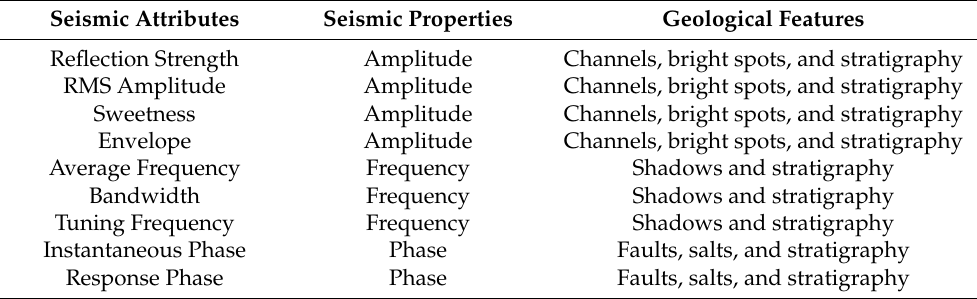
Table 1. Seismic attributes with key seismic properties and the geological applications. Seismic Attributes Seismic Properties Geological Features Reflection Strength Amplitude Channels, bright spots, and stratigraphy RMS Amplitude Amplitude Channels, bright spots, and stratigraphy Sweetness Amplitude Channels, bright spots, and stratigraphy Envelope Amplitude Channels, bright spots, and stratigraphy Average Frequency Frequency Shadows and stratigraphy Bandwidth Frequency Shadows and stratigraphy Tuning Frequency Frequency Shadows and stratigraphy Instantaneous Phase Phase Faults, salts, and stratigraphy Response Phase Phase Faults, salts, and